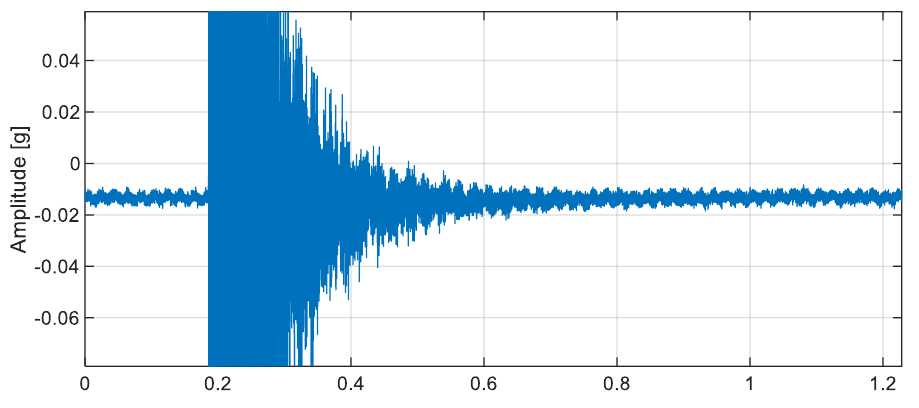
Figure 4. Approximation of pulse damping time.